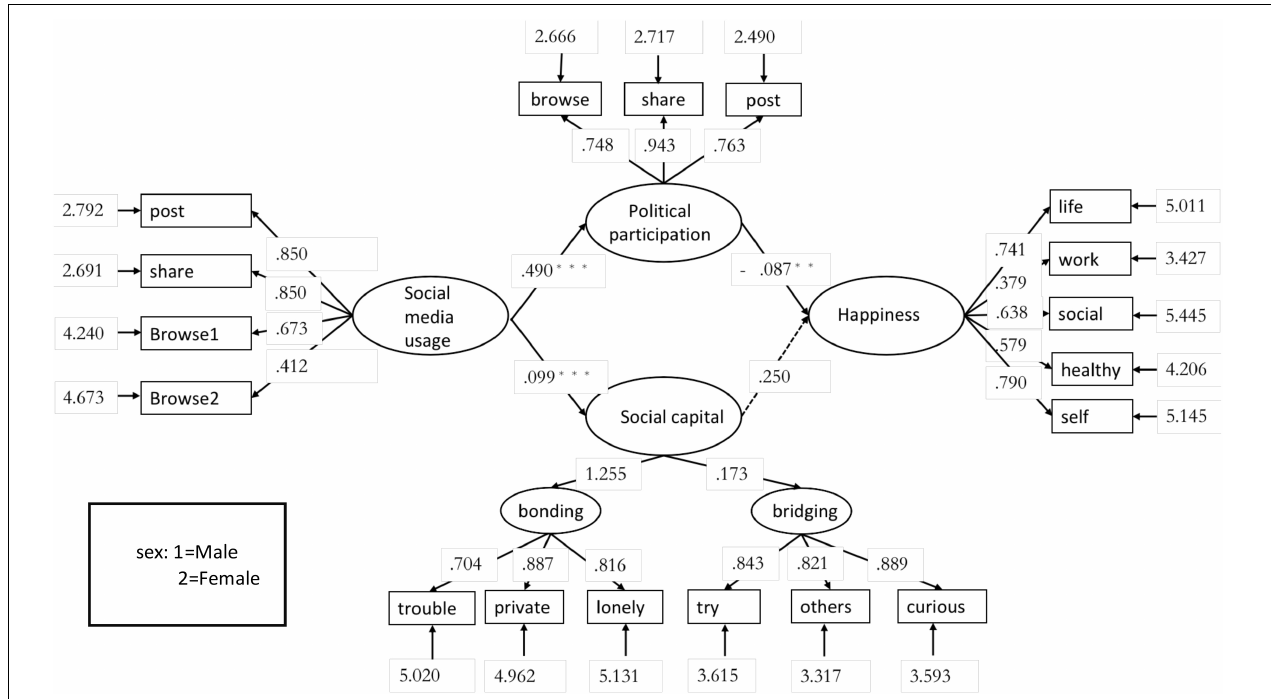
FIGURE 1 | A measurement model of the relationship between frequency of social media use, online political participation in the community, social capital, and well-being. *** means p < 0 . 001, **means p < 0 . 01.